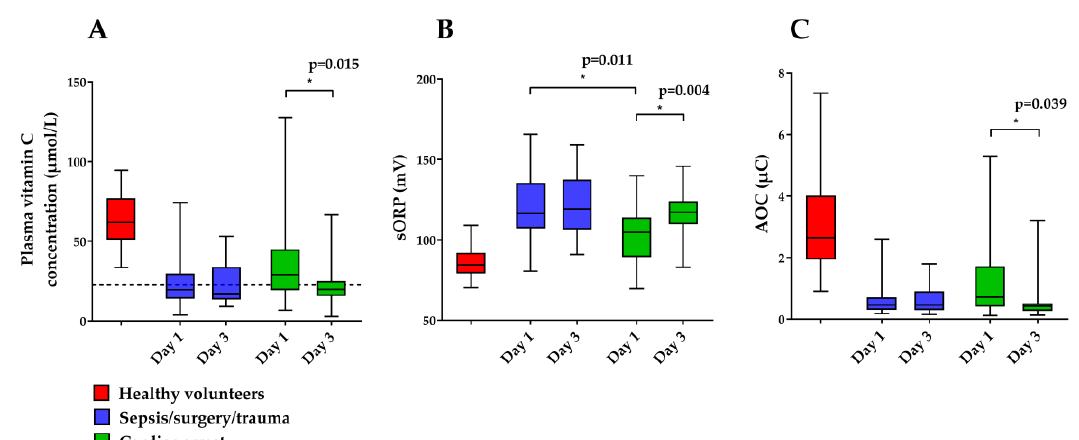
Figure 3. Boxplots of plasma vitamin C concentrations ( A ), static oxidation reduction potential (sORP) ( B ) and antioxidant capacity (AOC) ( C ) in the vitamin C status study at day 1 and 3. The dashed line ( A ) represents the lower limit of normal plasma vitamin C concentrations (23 µmol/L). sORP and AOC were measured in non-acidified samples.